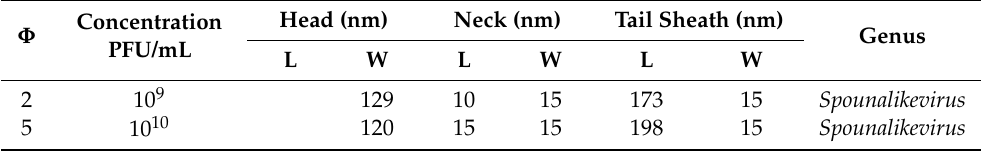
Table 2. Characteristics of bacteriophages against A. hydrophila strains.